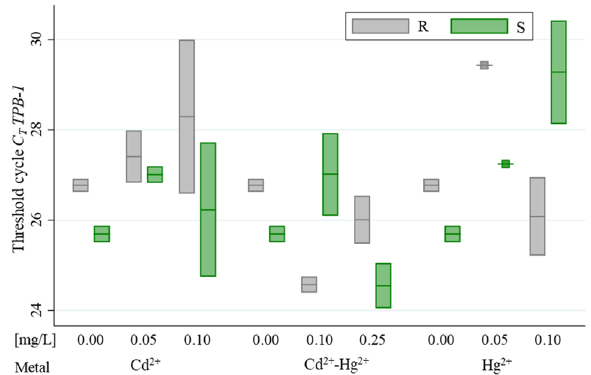
Figure 4. Mean of C T for the gen TBP-1 of L. perenne exposed to de different treatments (R: root and S: